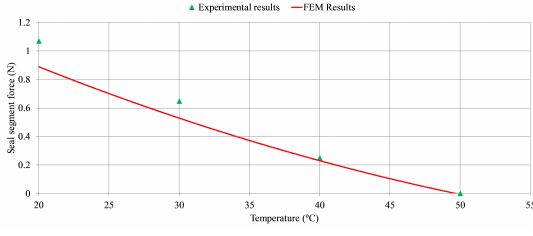
Figure 7: Brush seal with bimetal elements force as a function of interference and